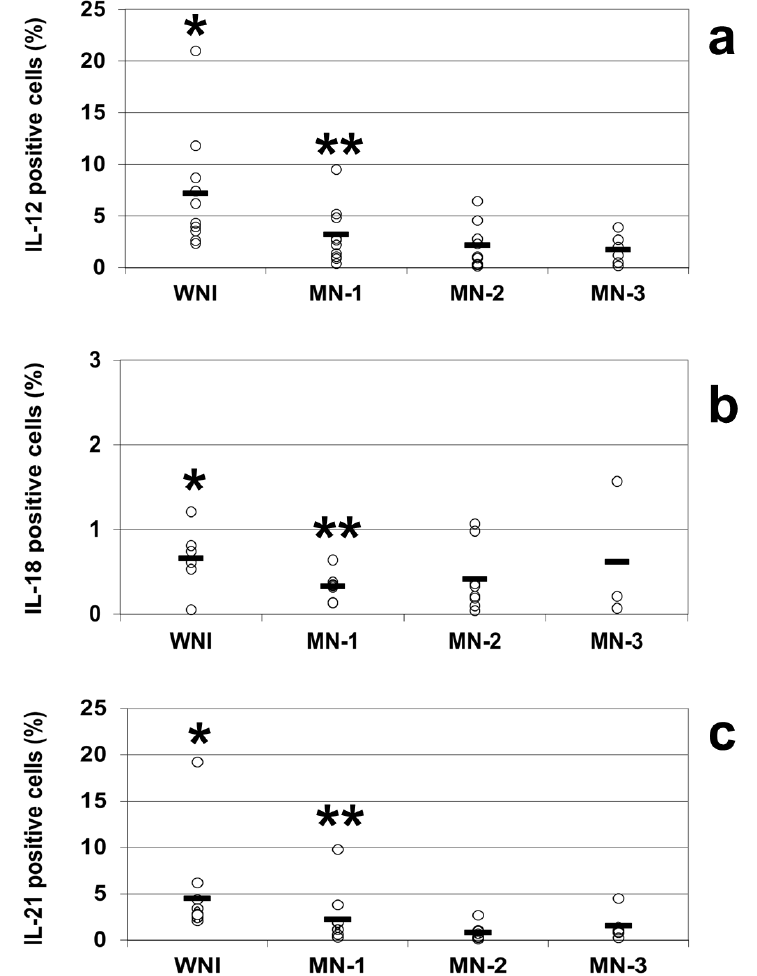
Figure 2. Percentages of positive cells from well-nourished and malnourished children, IL-12 ( a ), IL-18 ( b ), and IL-21 ( c ) were analyzed by flow cytometry in WNI, MN-1, MN-2 and MN-3. Cells were stained and analyzed as described in the Methods section. Data are based upon flow cytometric analysis of 10,000 events. Results are expressed as percentage of positive cells and are showed individual data and the mean represented by the